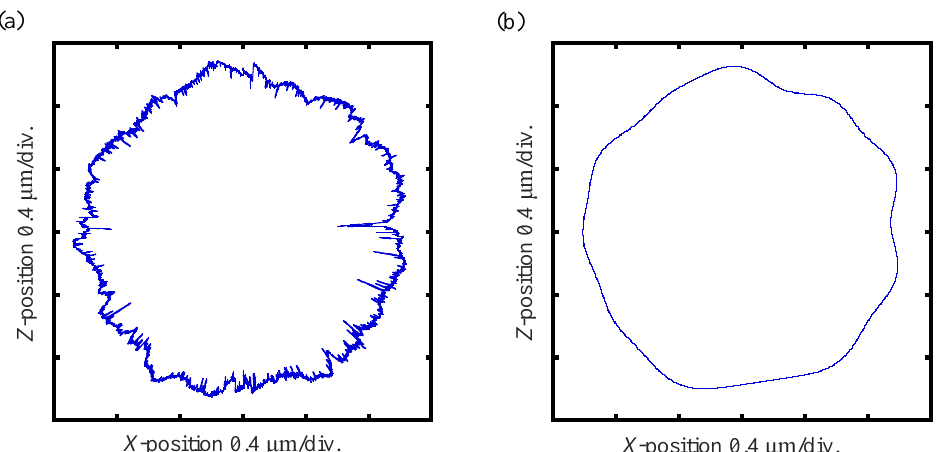
Figure 21. Cross-correlation coefficients observed in the stitching operations of the arc-profiles obtained by measuring the workpiece with a diameter of 1.5 mm.